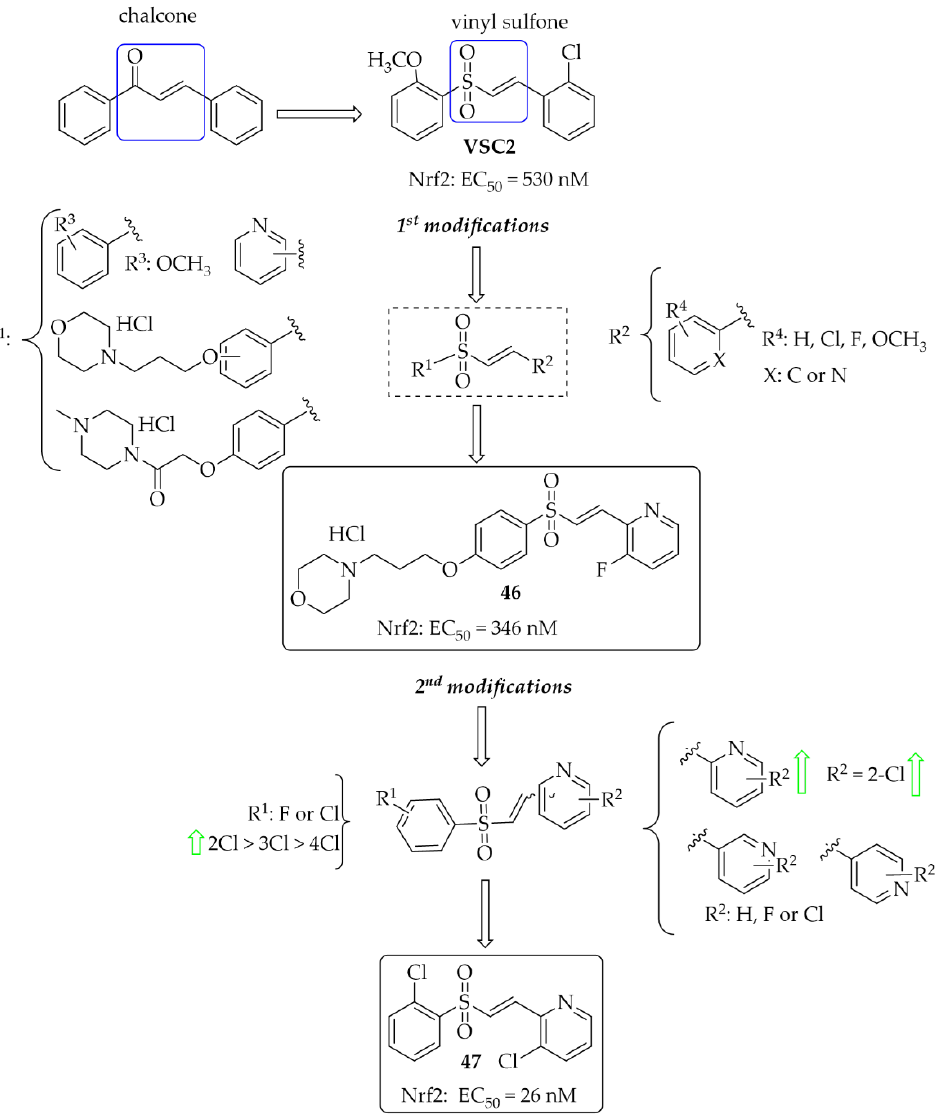
Figure 35. Design and structures of the most potent vinylsufonyl Nrf2 activators synthesised by Chen et al. [82,83]. Chen et al.